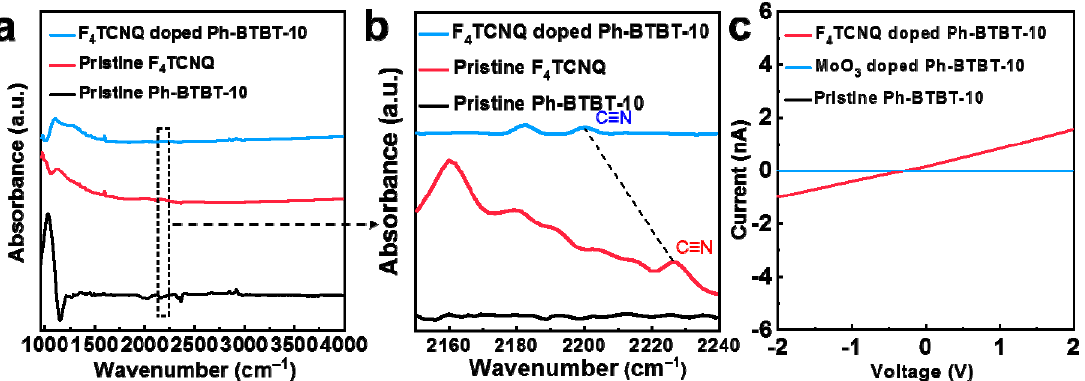
Figure 4. ( a , b ) Infrared (IR) spectra of pristine Ph-BTBT-10, pristine F 4 TCNQ and F 4 TCNQ-doped Ph-BTBT-10 film. ( c ) I - V curves of pristine Ph-BTBT-10, F 4 TCNQ-doped Ph-BTBT-10 and MoO 3 -doped Ph-BTBT-10 film. Curves of pristine and MoO 3 -doped Ph-BTBT-10 superposed. The channel length was 45 μ m and the channel width was 200 μ m. The thickness of Ph-BTBT-10 thin film was kept constant at 11.2 nm.